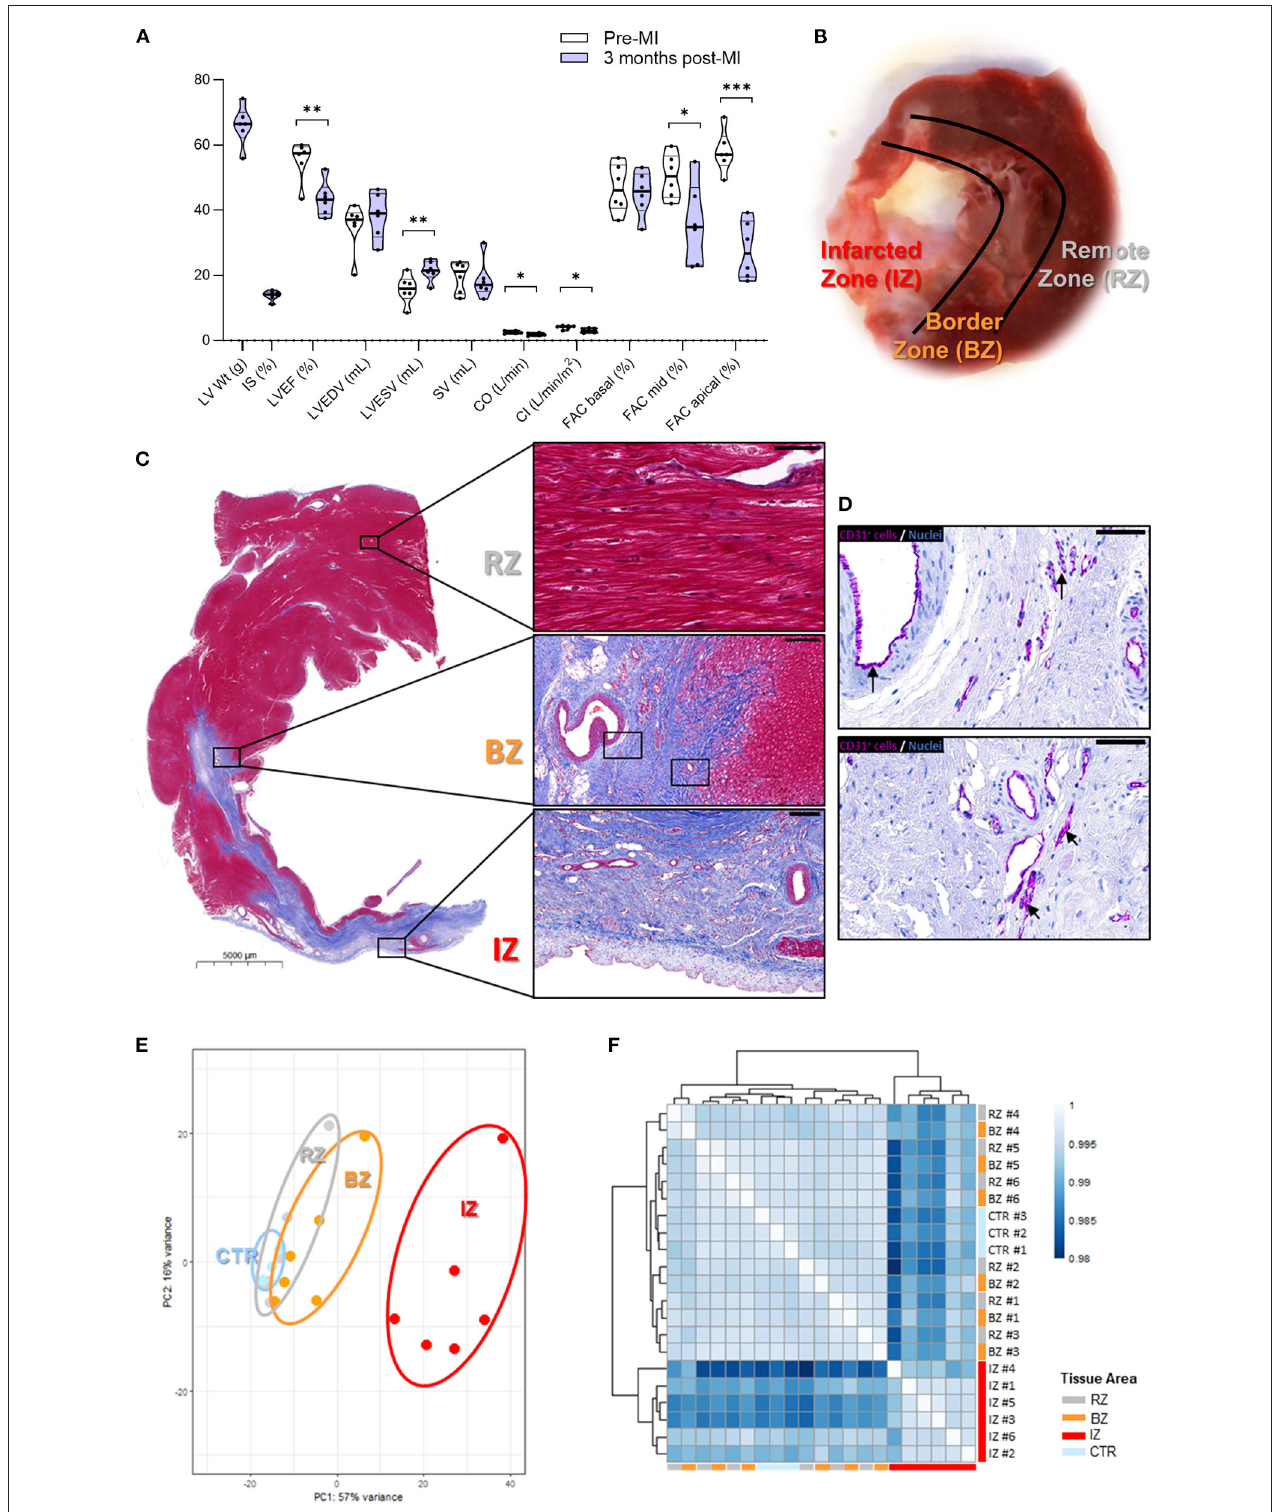
FIGURE 1 | Gene expression profiling in different areas of chronic infarcted porcine hearts. (A) Global cardiac functional indices before, and 3 months after MI. LV Wt, left ventricular weight; IS, infarct size; LVEF, left ventricular ejection fraction; LVEDV, left ventricular end-diastolic volume; LVESV, left ventricular end systolic volume; SV, stroke volume; CO, cardiac output; CI, cardiac index; FAC, fractional area change. Data are shown as Violin plots with individual datapoints corresponding to each